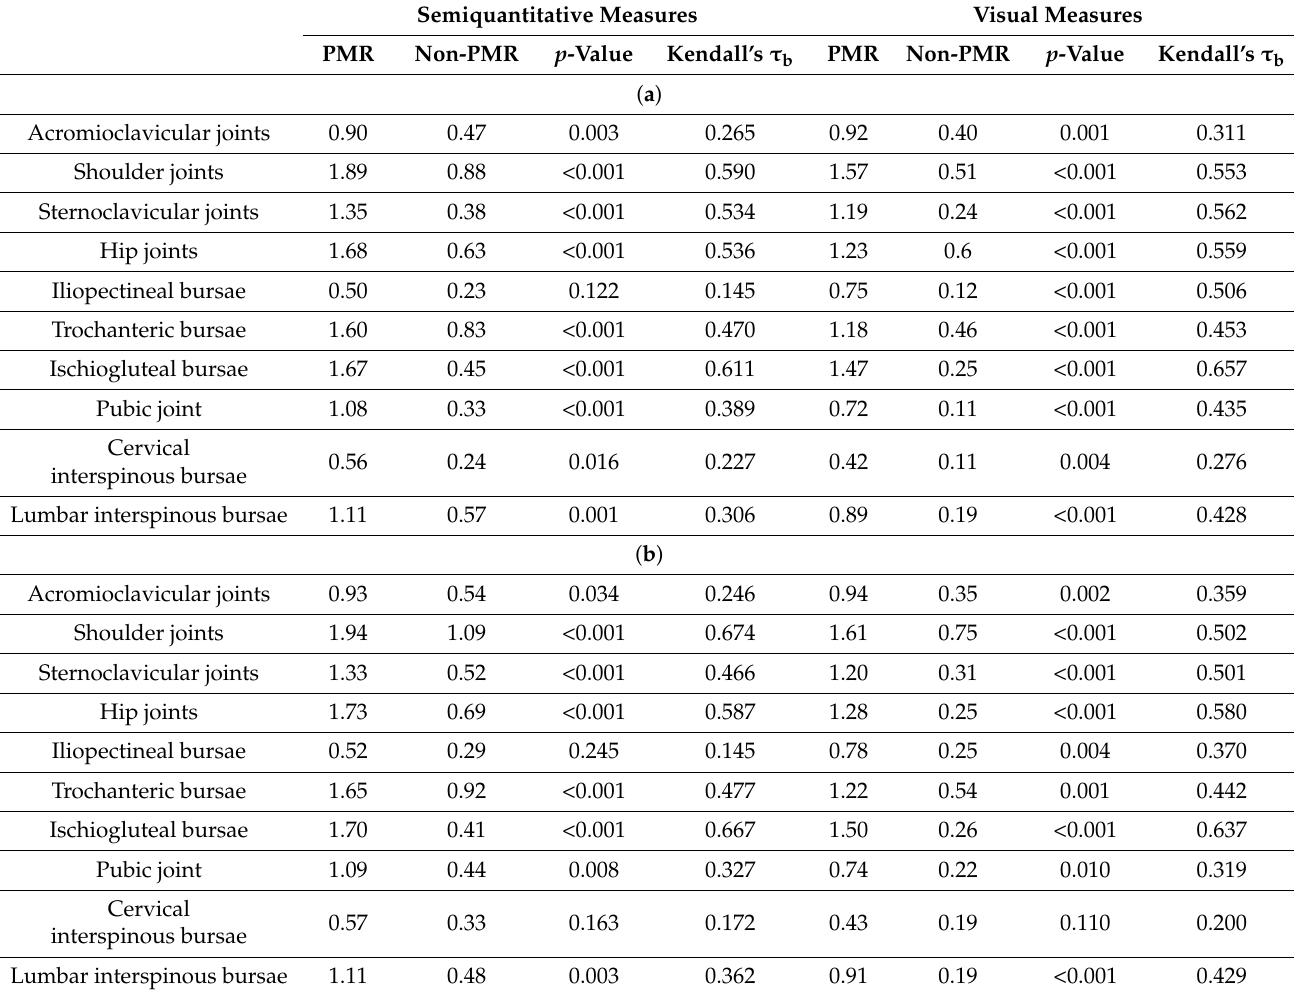
Table 2. ( a ) Mean values of semiquantitative and visual scores in glucocorticoid-naïve patients by all referral diagnoses ( n = 198). ( b ) Mean values of semiquantitative and visual scores in glucocorticoid- naïve patients suspected of PMR at referral ( n =